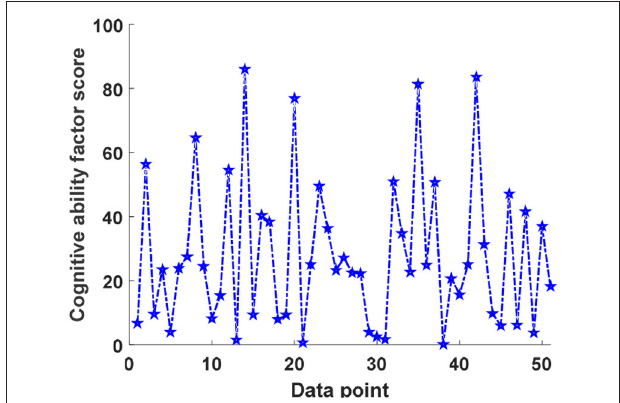
FIGURE 5 | Line chart of cognitive ability factor scores and depression factor scores for different data points. The *symbol indicates the child who takes the cognitive ability test. Y-axis indicates score. There are 51 children in the test.